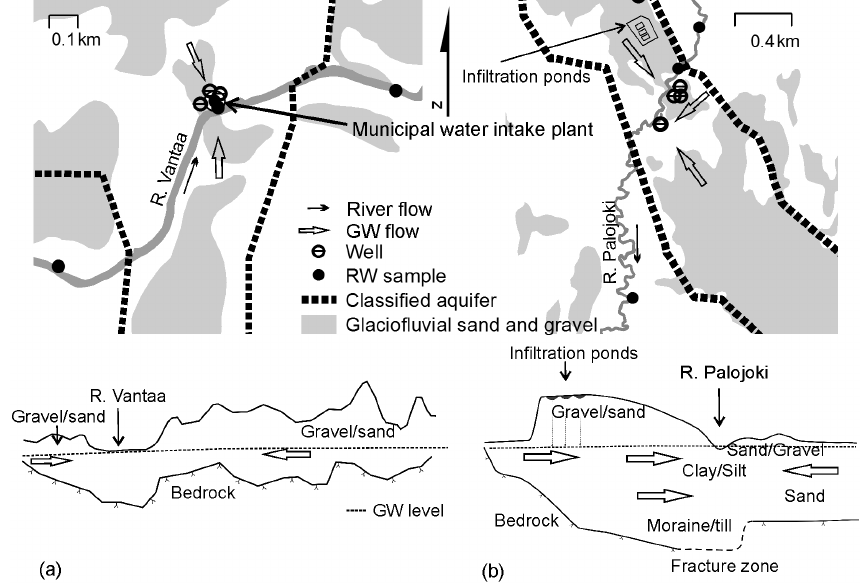
Figure 3. Schematic diagrams of the field study sites: (a) Hyvinkäänkylä field study site (bedrock elevation data from Breilin et al., 2004), and (b) River Palojoki field study site (modified from Kortelainen and Karhu, 2006). (Basemap Database © National Land Survey of Finland 2010; Quaternary Deposit Database © Geological Survey of Finland 2008; Groundwater Database © SYKE 2010; Watershed Database © SYKE